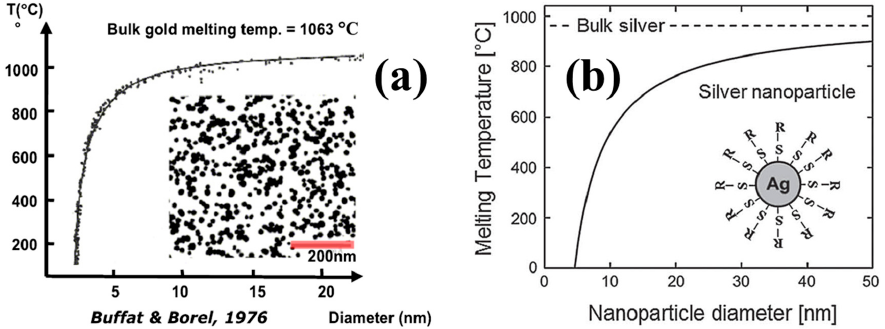
Figure 3. Experimental and theoretical values of the melting point temperature of ( a ) gold particles. Reproduced with permission from [61]. Copyright 1986 American Physical Society; ( b ) silver particles as the function of decreasing particle size; reproduced with permission from [62]; Copyright 2006